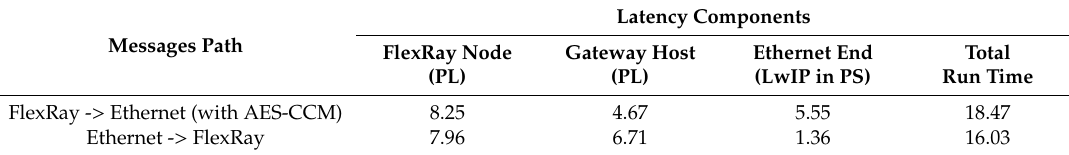
Table 5. Execution Time ( µ s) of the message